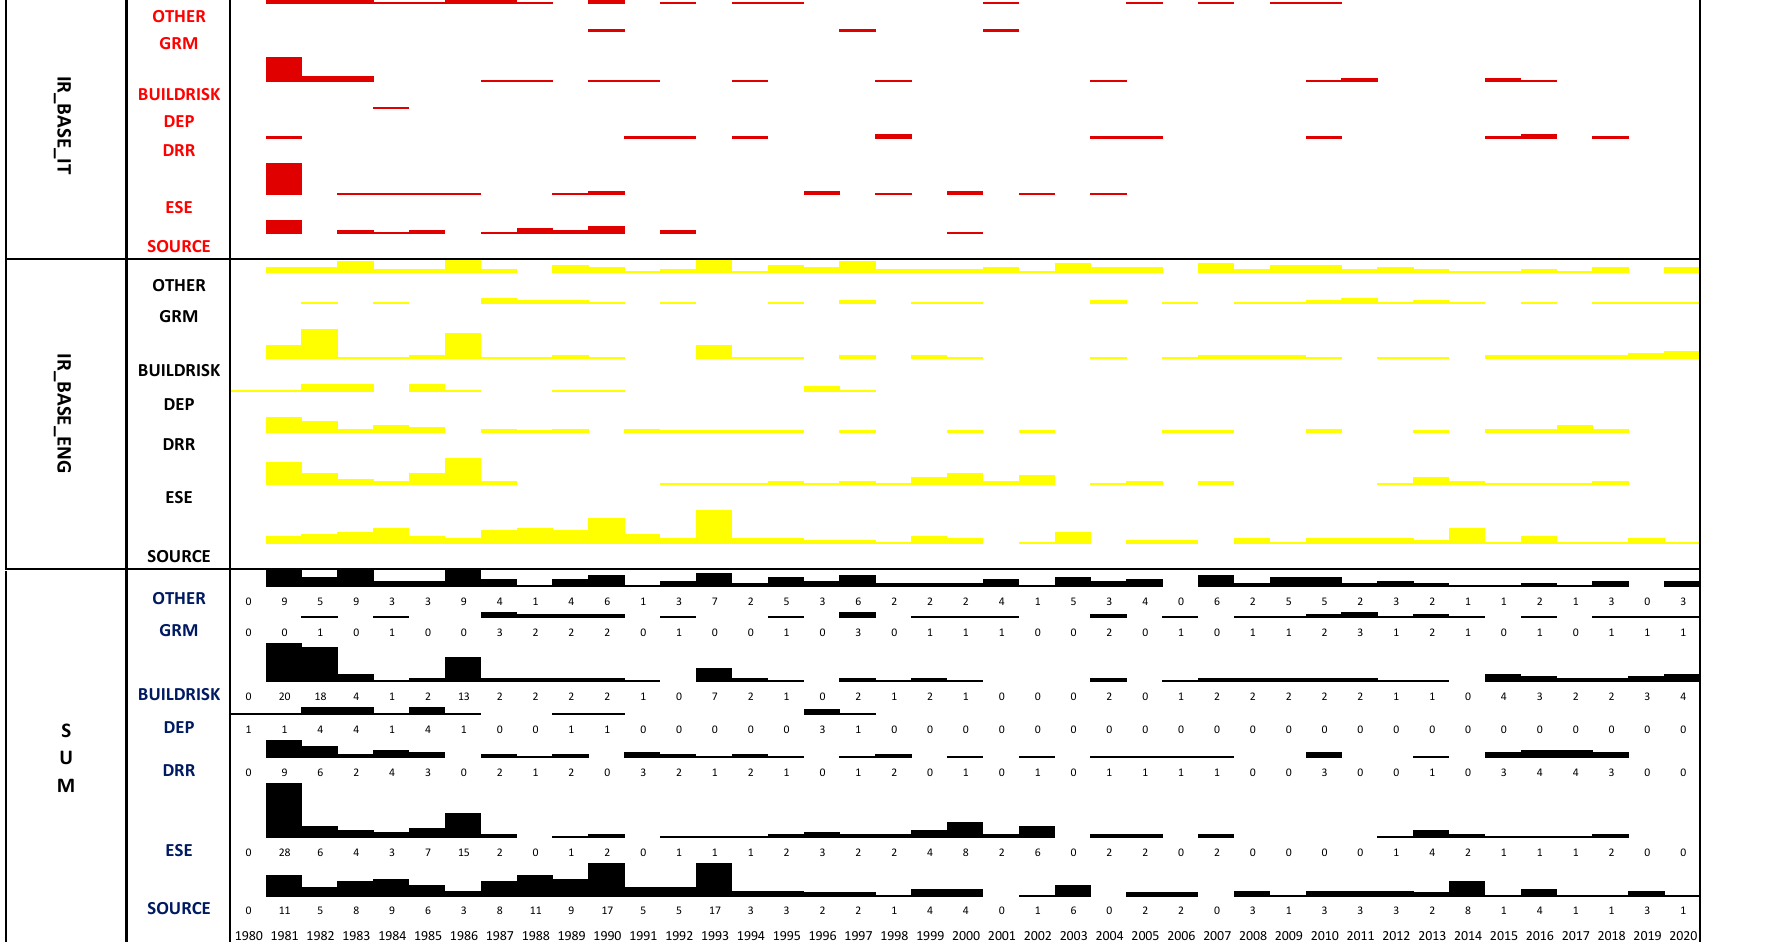
Figure 8. Number of records for each topic over time.